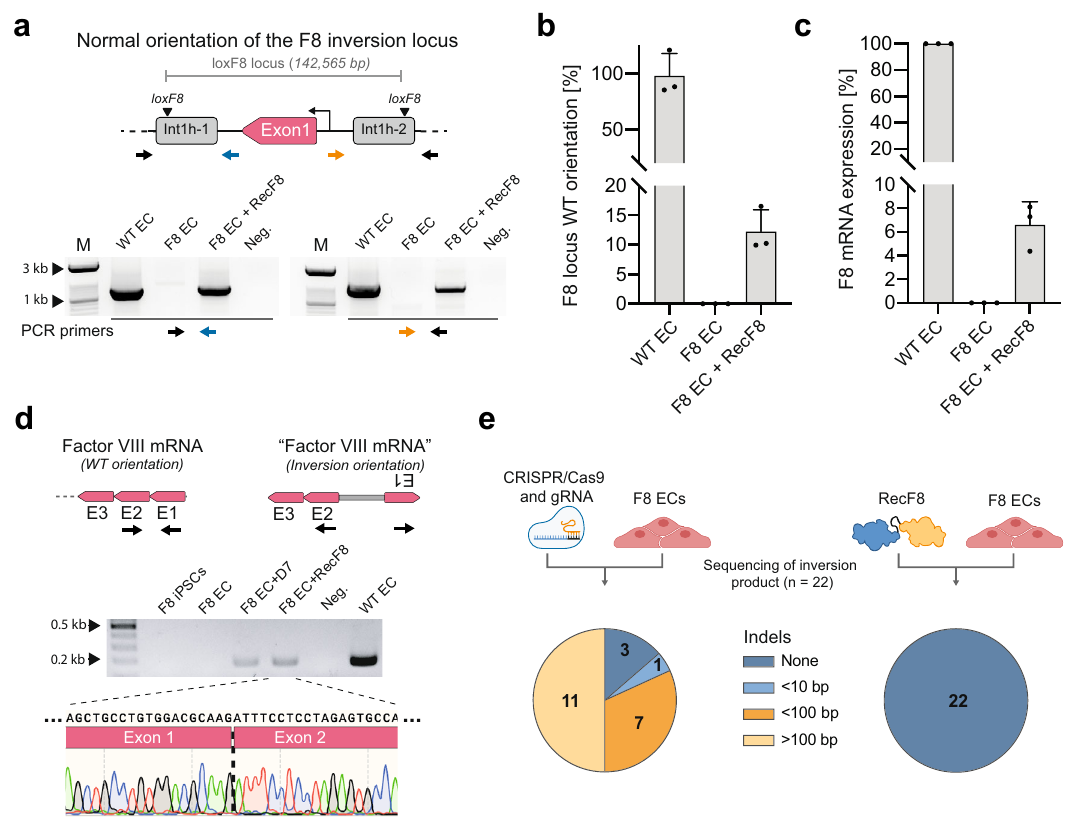
Fig. 6 Functional correction of patient-speci fi c endothelial cells differentiated from iPSCs. a RecF8 expression corrects the int1h inversion. Overview of primer arrangement around the fi rst and second loxF8 site to detect the orientation of the 140 kb fragment (top panel). Agarose gel of PCR products obtained on genomic DNA from patient-speci fi c ECs with or without treatment with RecF8 (lower panel). Marker (M) lanes at 1 kb and 3 kb are indicated. WT EC = ECs differentiated from a donor that does not carry the exon 1 inversion. F8 EC = ECs differentiated from a hemophilic donor carrying the exon 1 inversion. ‘ + RecF8 ’ = cells were transfected with RecF8 mRNA. Neg. = water control. b qPCR-based quanti fi cation of the genomic inversion ef fi ciencies in patient-speci fi c ECs with and without RecF8 treatment. Inversion quanti fi cation of WT ECs is shown as reference ( n = 3, replicates are shown as dots). Error bars represent standard deviation of the mean (SD). c qPCR-based quanti fi cation of Factor VIII mRNA transcript. The relative expression of the Factor VIII mRNA was measured after treating patient-speci fi c ECs with or without RecF8 mRNA ( n = 3, replicates are shown as dots). Error bars represent standard deviation of the mean (SD). Factor VIII mRNA expression in untreated WT ECs was used for normalization. d Schematic depiction of the fi rst three exons of the Factor VIII mRNA and the primers used for detecting the transcript. A gel image and sequencing read of Factor VIII cDNA of RecF8 treated patient-derived ECs is shown. The exon1 – exon2 boundary can only occur, if the inversion is corrected to the WT orientation, the gene is transcribed and the pre-mRNA spliced correctly. e Quanti fi cation of indels introduced by CRISPR/Cas9 or RecF8 after inverting the loxF8 genomic locus. Counts of clones harboring different kinds of indels are shown in the pie charts. 22 clones were analyzed for each condition. Parts of the fi gure were created with BioRender.com. Source data are provided as a Source data fi